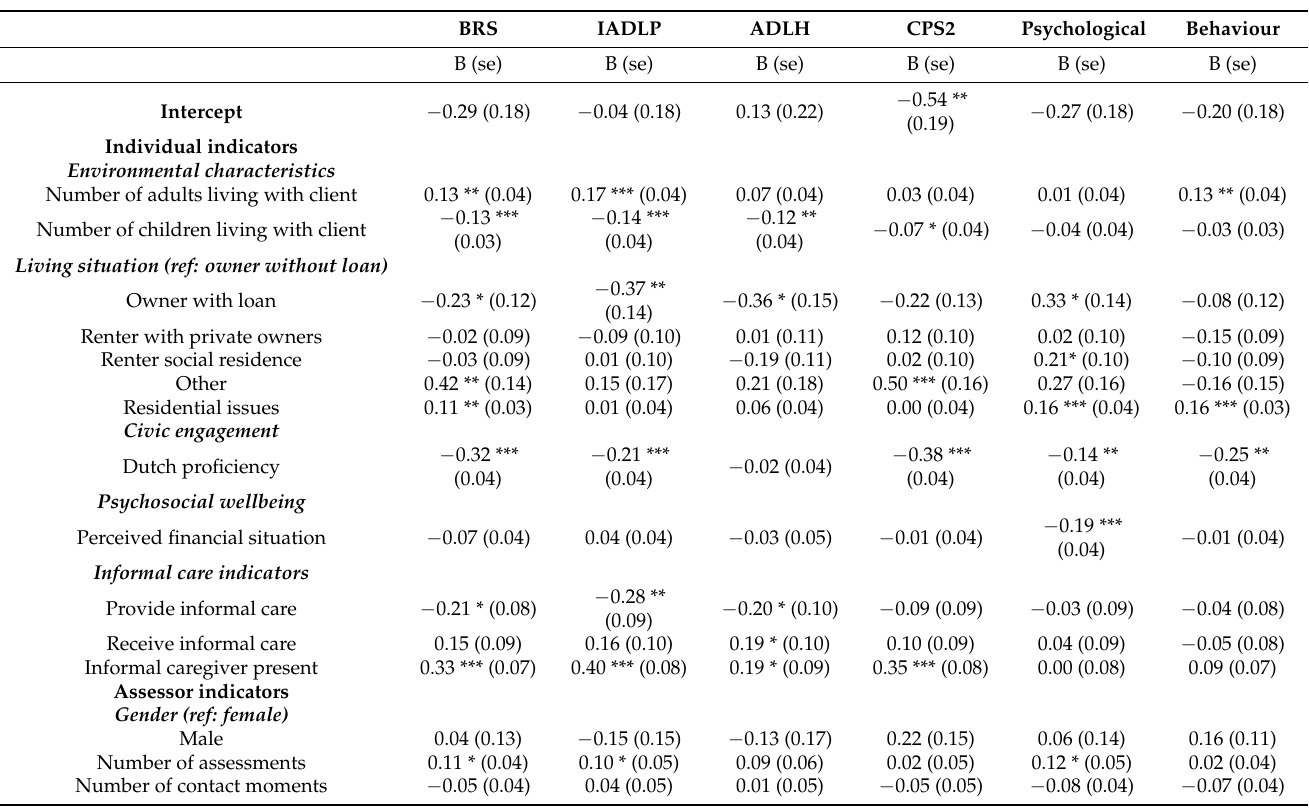
Table A3. Multilevel regression analyses of client- (excluding feelings of depression) and assessor-level variables on assessment